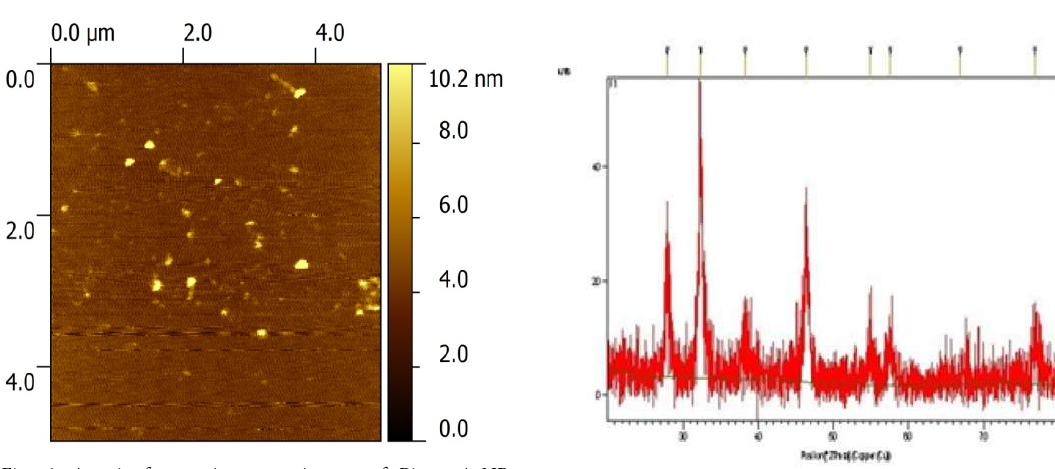
Fig. 7. XRD patterns of biosynthetic silver nanoparticles at 2 Ɵ showing prominent peak at 38 and 46.